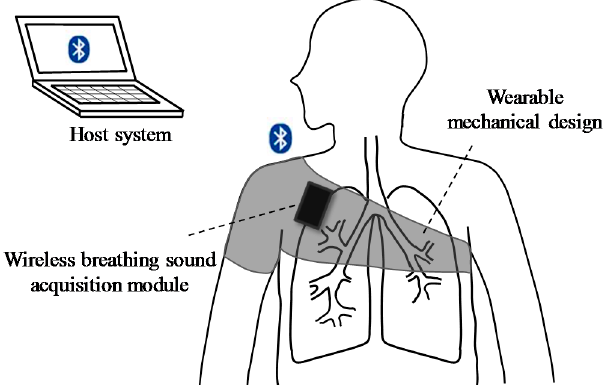
Figure 1. Basic scheme of proposed wearable and wireless breathing sound monitoring system.